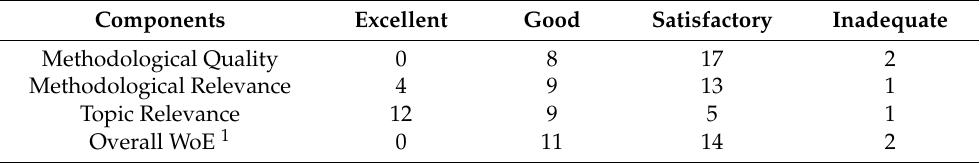
Table 4. Weight of evidence